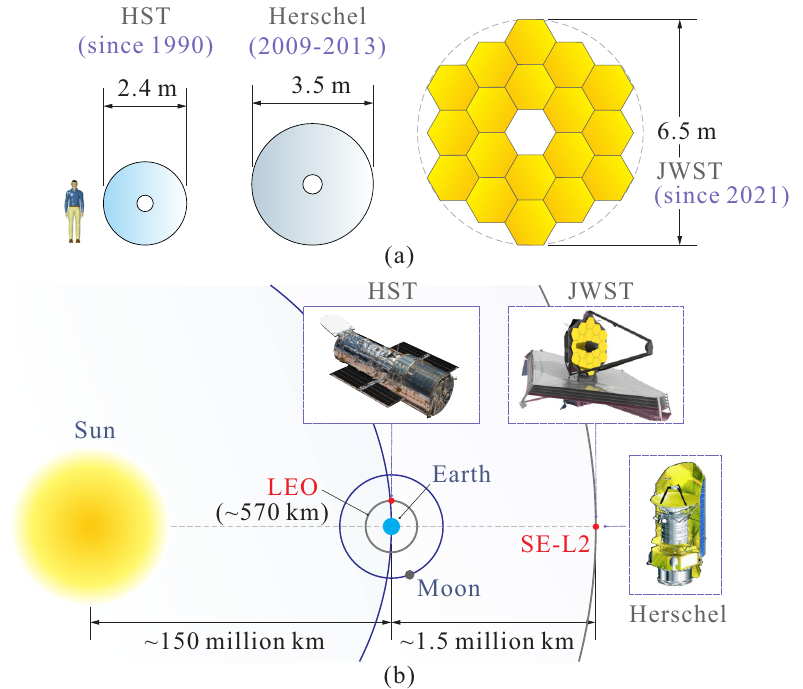
Figure 1. ( a ) Comparisons of the sizes of the primary mirrors of HST, Herschel, and JWST (with a reference height of 1.8 m); ( b ) orbital information of space